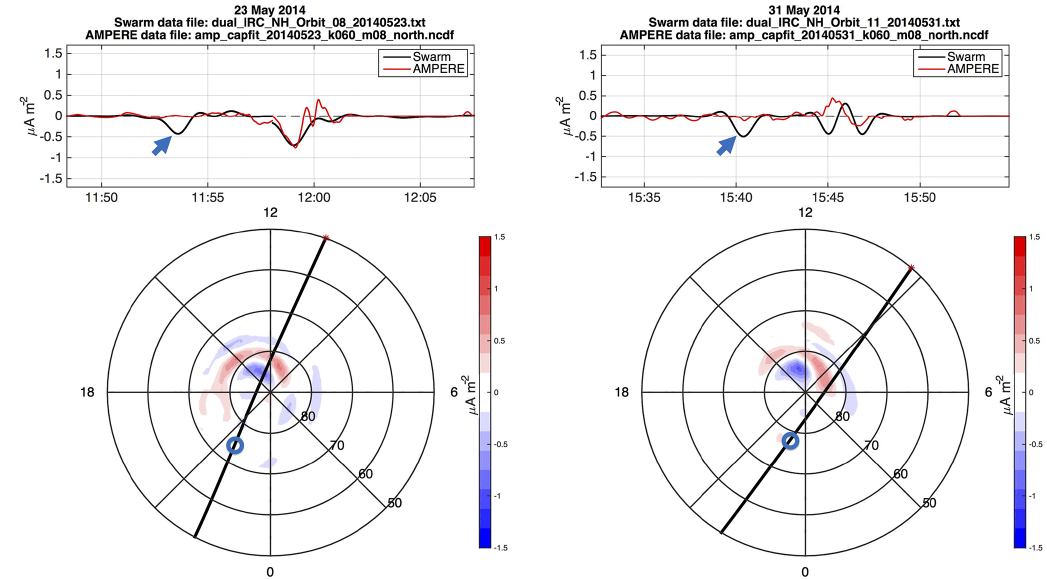
Figure 12. Comparison of Swarm and AMPERE field-aligned current estimates. In the top panels, time series along the Swarm track are compared. Occurrences of high-latitude FACs in Swarm records are marked by arrows in the top and by circles in the bottom plots. The FAC distribution derived from AMPERE is an average over the time 11:58–12:08UT (left frames) and 15:44–15:54UT (right frames). Swarm data are adapted to AMPERE conventions; plotted are radial currents (positive outward) low-pass-filtered with a 60s cutoff period.